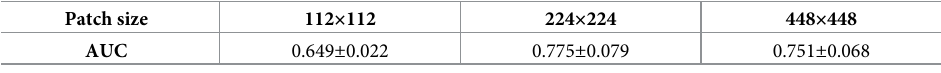
Table 4. Slide-level hold-out testing AUCs on H&E-stained slides using BCR-Net (K = 5000) in different patch sizes. Values are reported with mean ± standard deviation across the five